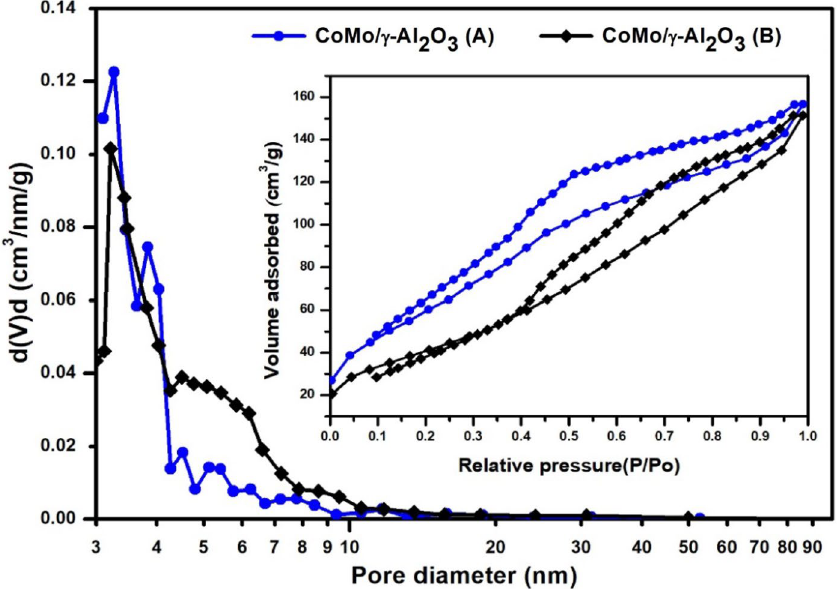
Figure 1. Pore size distribution and adsorption desorption isotherm of the CoMo/γ-Al 2 O 3 catalyst before ( A ) and after ( B )